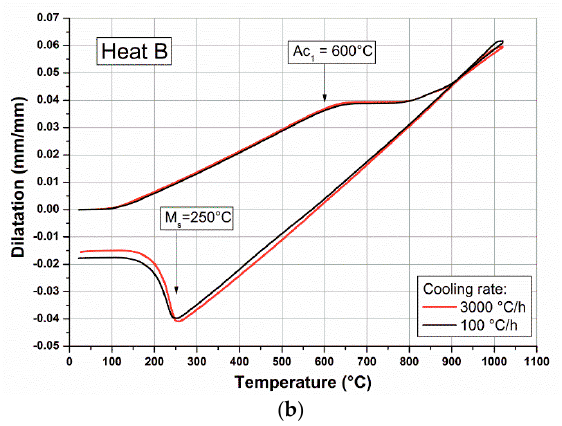
Figure 2. Dilatometric curves of ( a ) Heat A and ( b ) Heat B.